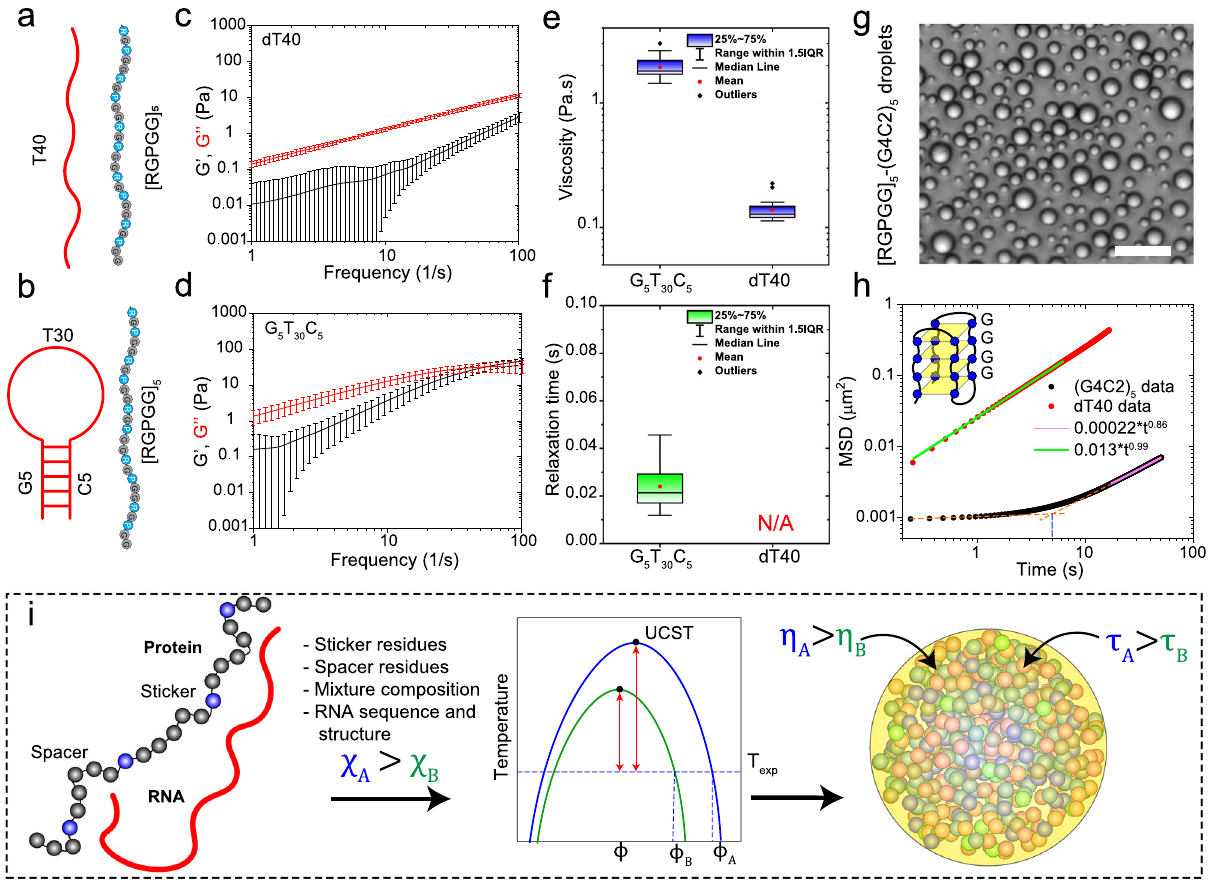
Fig. 6 Effect of RNA sequence and structure on the LVE properties of peptide-RNA condensates. a A scheme showing the sequence and expected disordered structure of the peptide and dT40. b A Scheme showing the sequence and expected structure of G 5 T 30 C 5 . c Average viscoelastic moduli of condensates formed by [RGPGG] 5 and dT40 as measured by pMOT. Error bars represent one standard deviation (±1 s.d.). d Average viscoelastic moduli of condensates formed by [RGPGG] 5 and G 5 T 30 C 5 as measured by pMOT. Error bars represent one standard deviation (±1 s.d.). e Zero-shear viscosity of [RGPGG] 5 -ssNA condensates for both structured (G 5 T 30 C 5 ) and unstructured (dT40) NA as calculated from the data in b and d . f Terminal relaxation time of [RGPGG] 5 -NA condensates for both structured (G 5 T 30 C 5 ) and unstructured (dT40) NA as calculated from the data in b and d . For the data in c – f , the sample size is n = (22 and 20) measurements over 3 independent samples for (dT40 and G 5 T 30 C 5 ), respectively. g Bright fi eld image of condensates prepared by mixing [RGPGG] 5 and (G 4 C 2 ) 5 NA at 5.0 mg/ml and 2.5 mg/ml concentrations, respectively. Scale bar is 20 µ m. h Mean squared displacement (MSD) of 200 nm polystyrene particles within condensates formed by [RGPGG] 5 peptide with dT40 (red) and (G 4 C 2 ) 5 (black). This data show that (G 4 C 2 ) 5 forms condensates that have substantially slower network dynamics as compared to the condensates formed by dT40. The orange dashed lines extrapolate the two behaviors ( fl at MSD at short lag-times and increasing MSD at long lag-times) and the blue line indicates the extrapolated transition point at ~5 s. i A scheme summarizing the relation between the strength of intermolecular interactions and LVE properties of peptide-RNA condensates. Comparison between two idealized systems A (blue) and B (green) is shown with interaction parameter χ A > χ B . Due to stronger interactions in system A, the difference between the phase separation temperature (blue curve) and the experimental temperature is greater, leading to a deeper quench within the two-phase regime (red double-sided arrows). Additionally, stronger interactions in system A cause higher viscosity η and a slower bond recon fi guration time τ , which retards the network fl